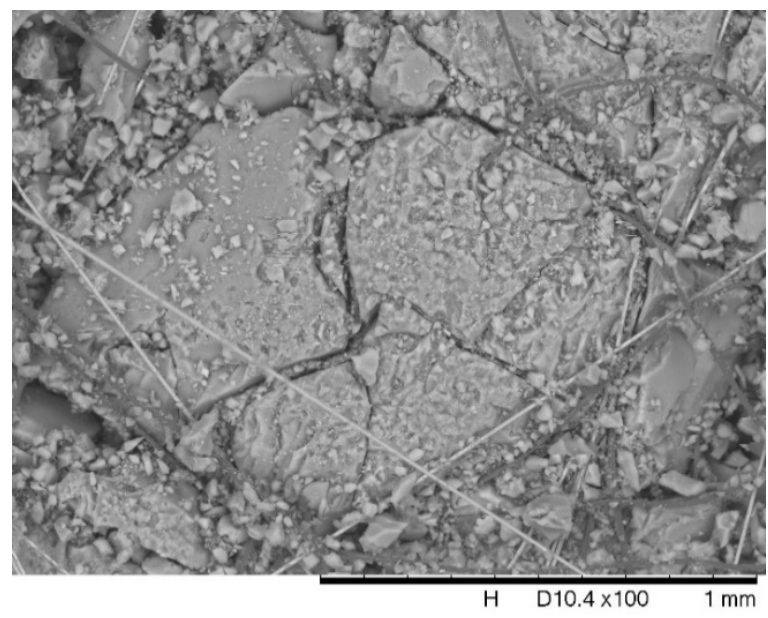
Figure 5. SEM image of the isochronally annealed sample.